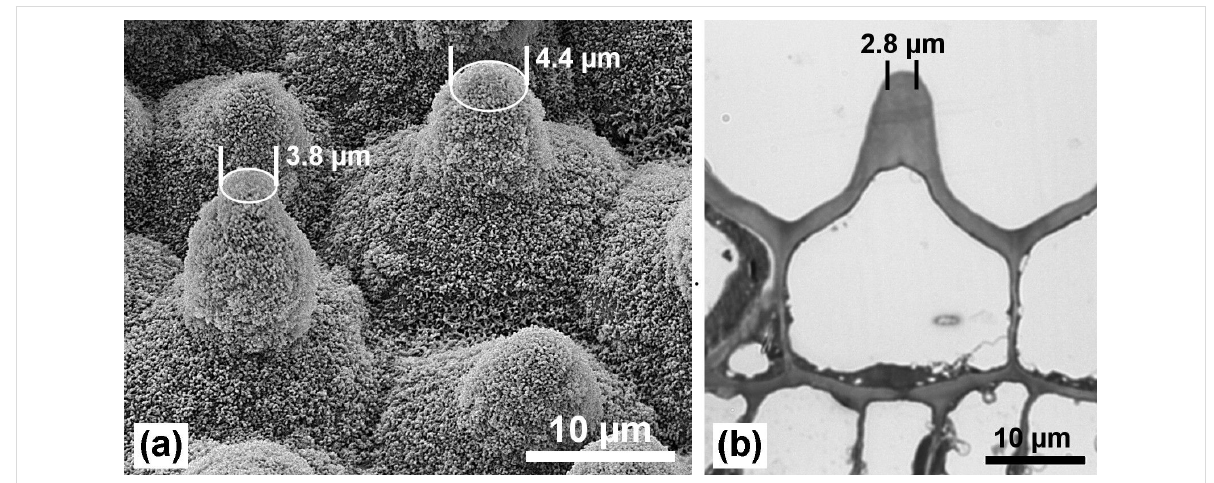
Figure 2: Epidermis cells of the leaf upper side with papillae. The surface is densely covered with wax tubules. (a) SEM image after freeze drying. (b) Light microscopy (LM) image of thin section of an embedded sample. Assuming a contact angle of >140°, for example, the area of heterogeneous contact between single papillae and water (marks) is small in comparison to the epidermis cell area.